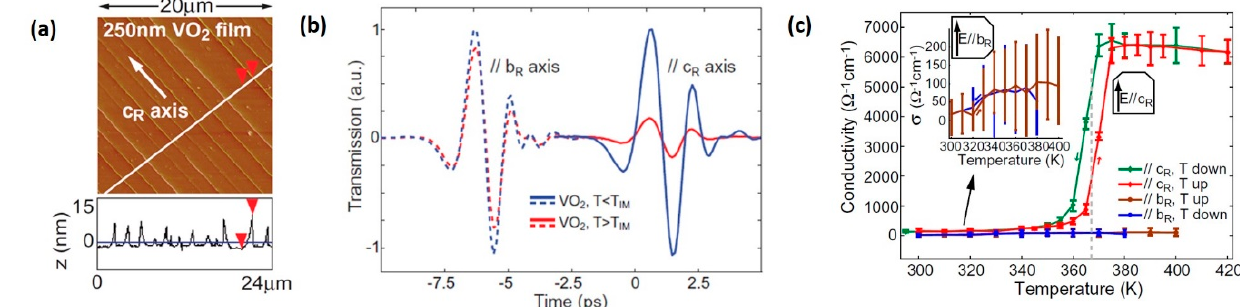
Figure 9. Anisotropic IMT through epitaxial strain engineering. ( a ) AFM phase image (0°–5° scale) and corresponding height profile of the 250 nm VO 2 /TiO 2 sample shows buckling-induced ridges along the c R axis. ( b ) THz transmitting waveforms along the c R and b R axis, below (blue) and above (red) the critical temperature T MI , normalized to the room- temperature value. The modulation depth along the b R axis (~15%) is dramatically different from that along c R (~85%). ( c ) Temperature dependence conductivity along the c R axis and b R axis in heating and cooling cycles. Reproduced from [130], with permission from Institute of Physics 2012.